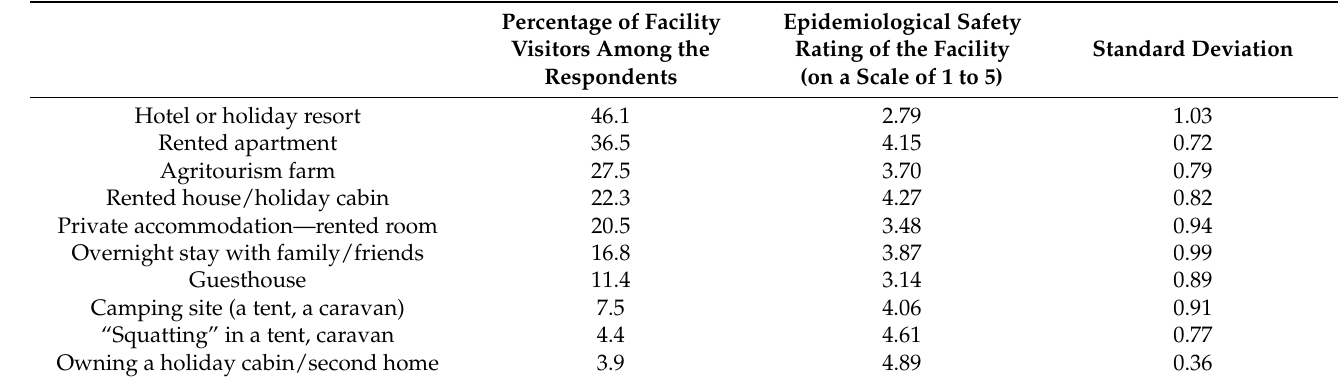
Table 5. Types of accommodation facilities used by the surveyed group and epidemiological safety rating of said facilities (in %, n = 386).